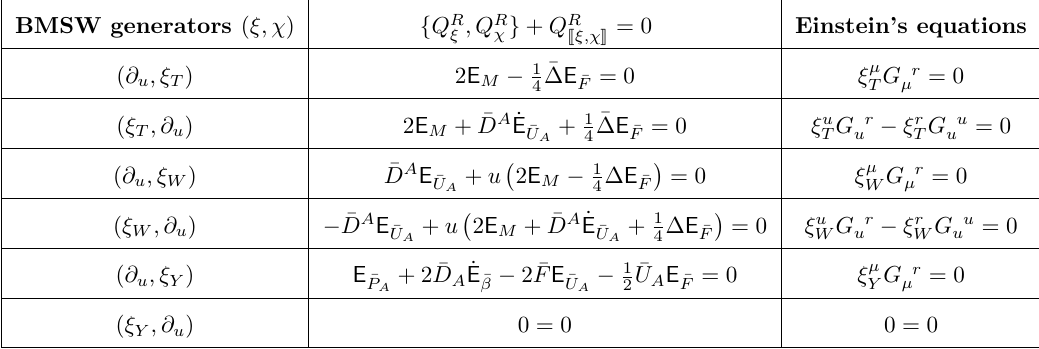
Table 1 . Synoptic overview of the flux-balance laws associated to the pair ( ξ, χ ) and their relation to Einstein’s equations. We recall that by the property (2.17) the charge algebra is left unchanged by the renormalization procedure.